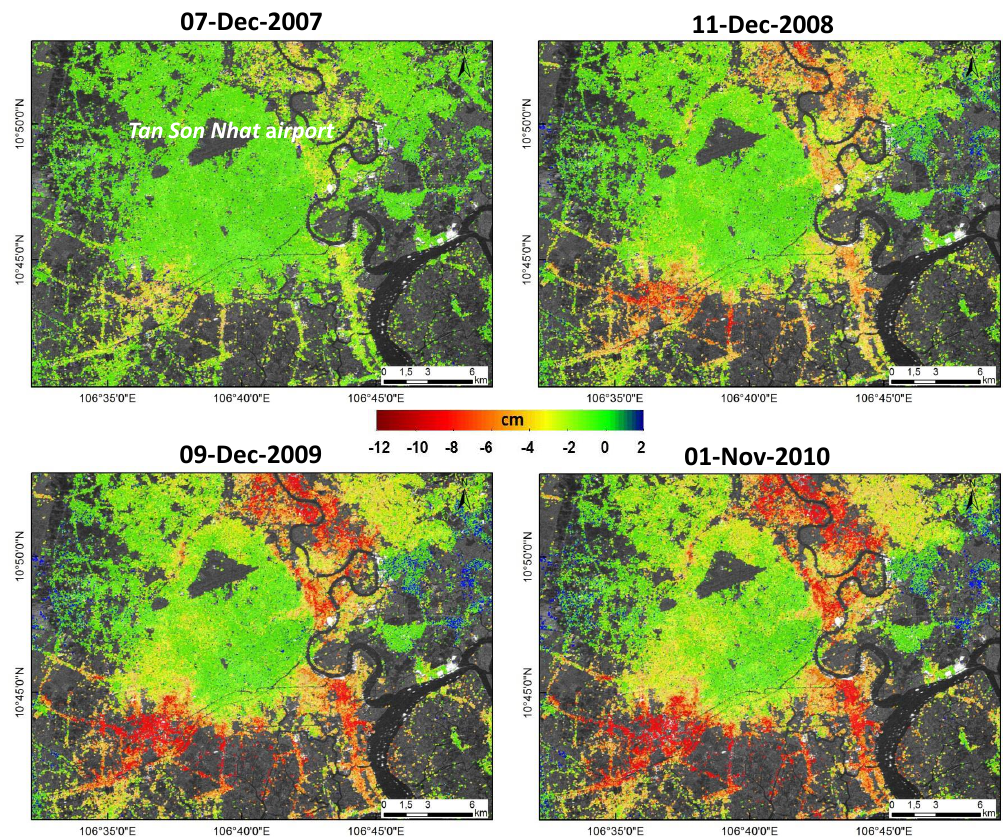
Figure 4. The vertical displacement history from 2006 to 2010. Positive velocities (blue colors) represent uplift; negative velocities (red colors) represent subsidence. The background is the average backscatter ALOS PALSAR